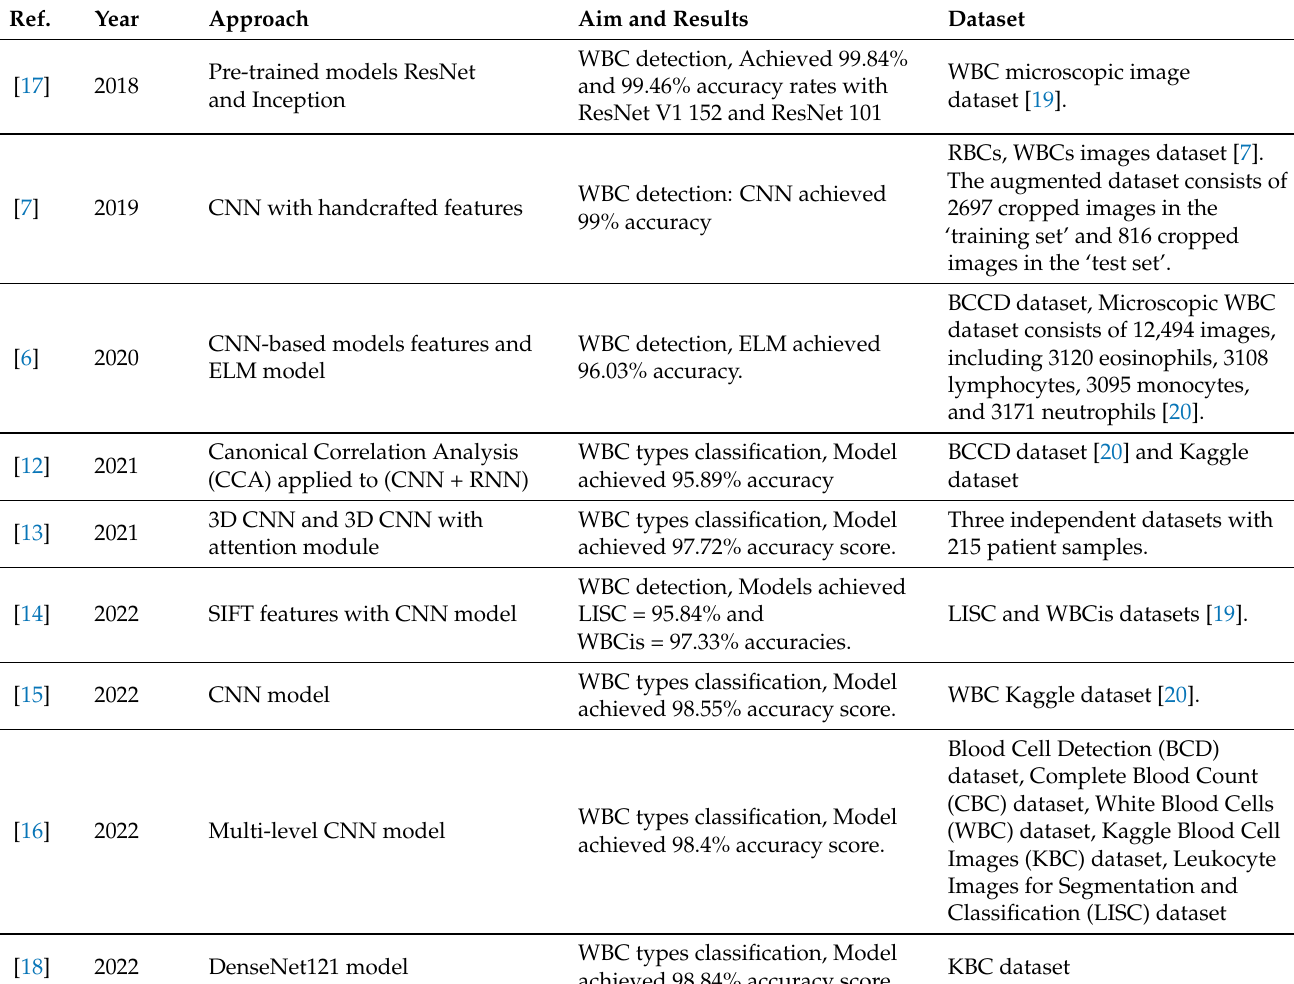
Table 1. Summary of literature